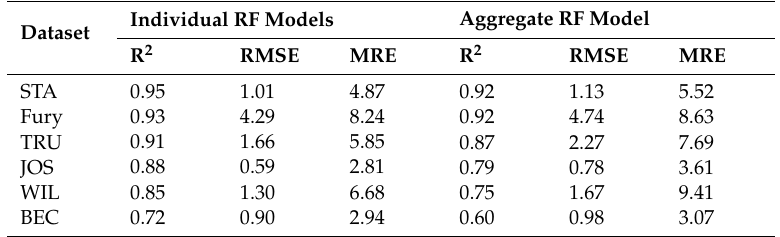
Table 4. Comparative results for the individual and aggregate RF regression models.